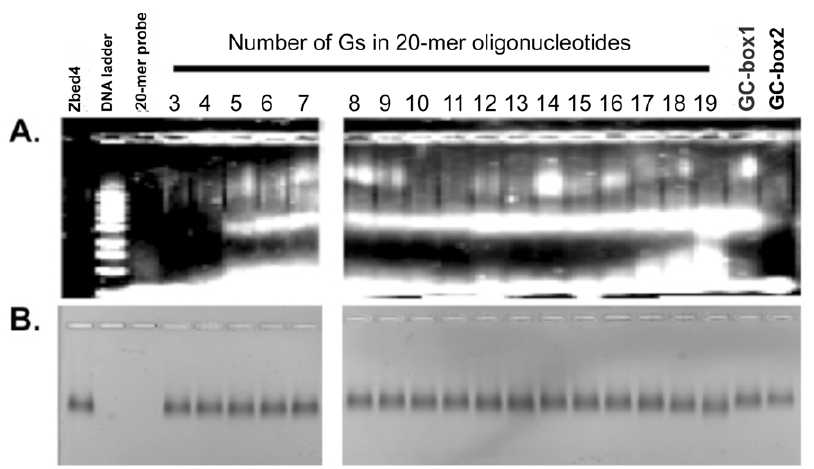
Figure 6. Determination of the minimal poly-G tract required for interaction with Zbed4 and of the affinity of Zbed4 for two different GC-box consensus sequences. Zbed4 (20 m g) was incubated with each of different 20-mer ssDNA primers containing G-tracts flanked by a different number of poly-As (0.5 nM), and with each of two GC-box consensus sequences for 45 min. The 20 m l reaction mixtures were loaded on a 1% agarose gel and EMSA was carried out as in Figure 5. A single primer (0.5 nM) and Zbed4 (20 m g) were used as controls. 1 kb DNA ladder was used as a standard for nucleic acid size. A. Agarose gel stained with SYBR Gold. B. The same gel stained with Coomassie R-250. As seen, the affinity of Zbed4 binds to for the oligonucleotides increases with the increasing number of Gs in the tracks. that contain at least 5 Gs and Quantification of the Zbed4-oligonucleotide complex bands showed that those with 5–11 Gs, 12–16 Gs and 17–18 Gs have similar density values: 105,415 6 15,217; 167,810 6 13,671; and 214,727 6 15,861, respectively. The complex with 19Gs has the highest value: 360,835. In addition, Zbed4 binds only to the GC- box, GGGGCGGGGC, indicating that the neighboring nucleotides of the core sequence are critical. doi:10.1371/journal.pone.0035317.g006 are present in the nucleus of Y79 cells, as it would be predicted if they are part of the same molecular complex. In addition, the merged image shows that Zbed4 is also present in the cells’ cytoplasm, around the nucleus (green staining).